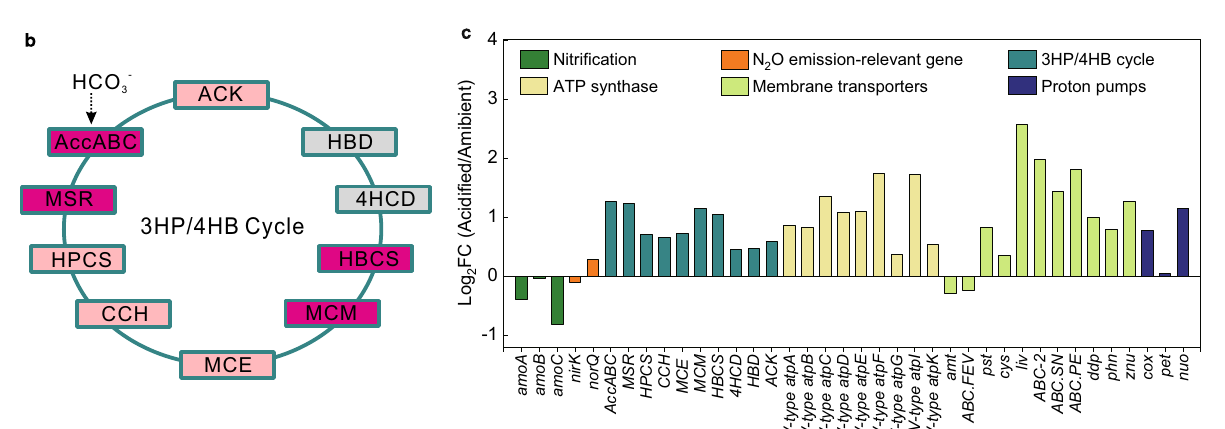
arrowsshowthemovementofelectrons. b Effectsofacidi fi cationontheexpression of genes involved in 3-hydroxypropionate/4-hydroxybutyrate cycle. Colors at the center of the protein pictograms indicate the extent of up- or down-regulation of gene transcripts encoding these proteins. Colors at the periphery of the protein pictograms correspond to bar colors in ( c ). c FC of transcripts encoding proteins showedin( a )and( b ).De fi nitionsoftheabbreviationsareshowninSupplementary Table 8. Source data are provided as a source data fi